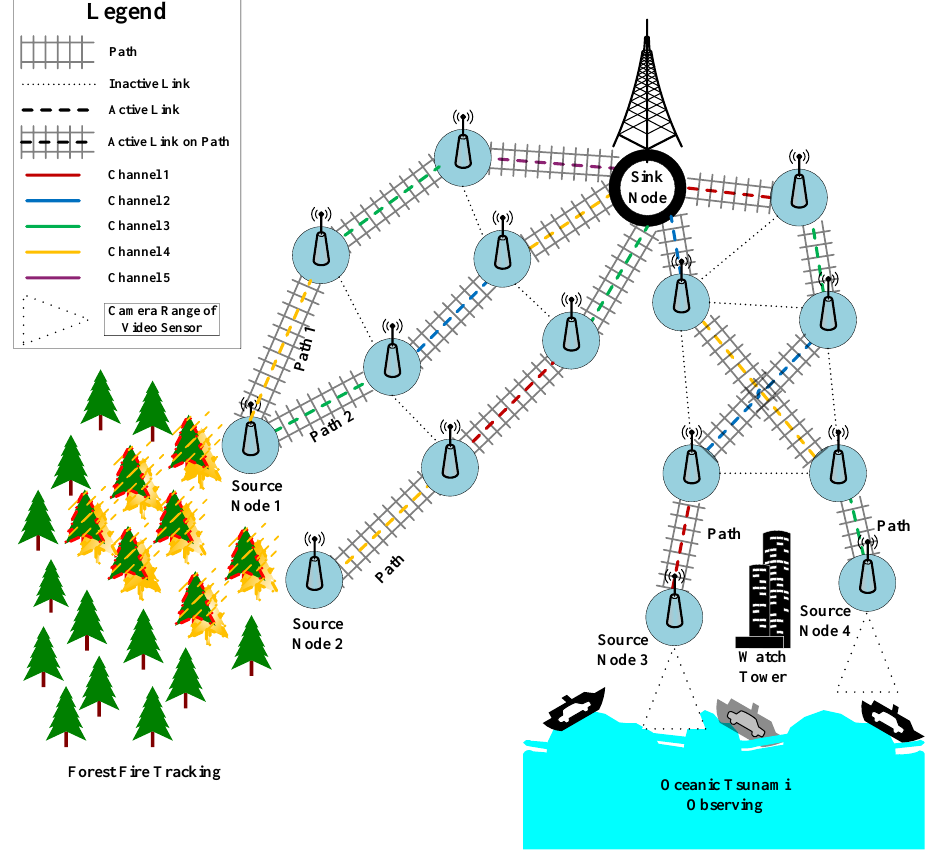
Figure 1. Surveillance using a multichannel/multipath